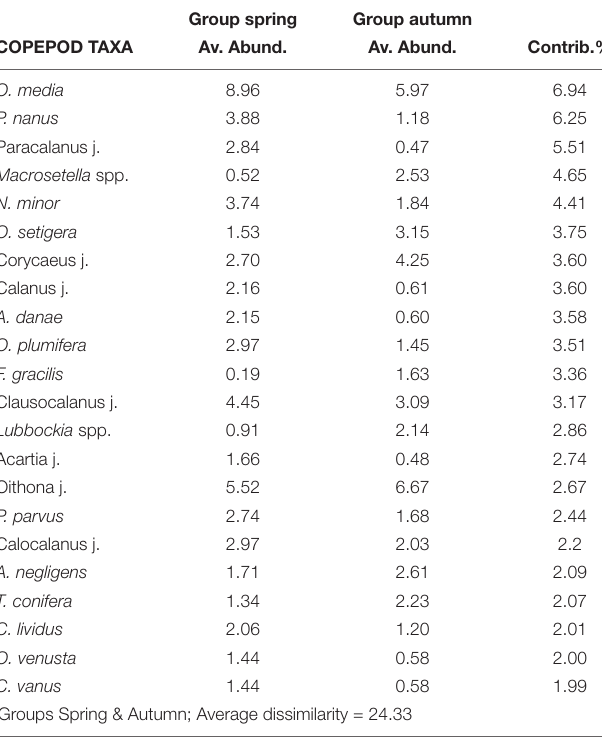
TABLE 3 | Most representative copepod taxa and their contribution (SIMPER analysis) to dissimilarity among pairs of samples selected by seasons (spring and autumn) considering all surveys and years (cut off 75%) using Bray Curtis similarity and abundance data (after square root